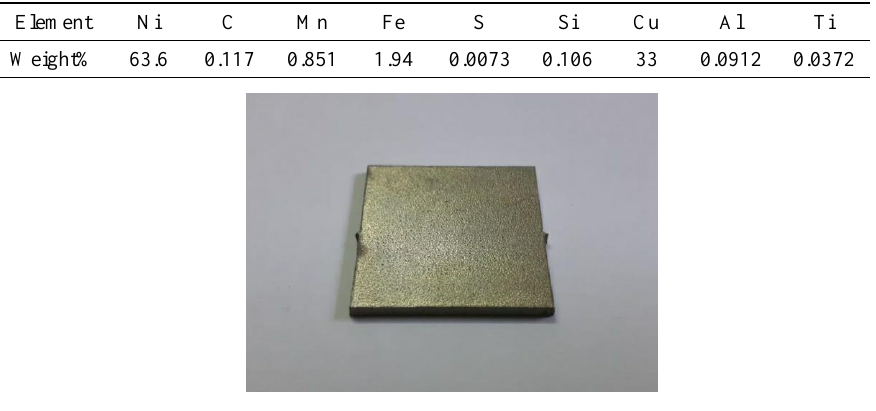
Fig. 1. Monel 400 workpiece.